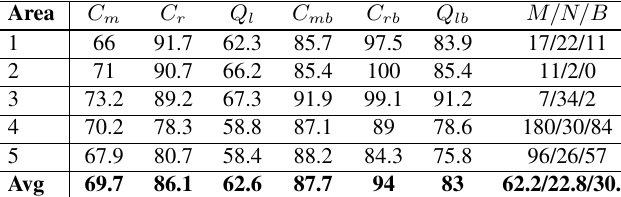
Table 3: Object-based evaluation of plane extraction results. Object-based: C m = completeness, C r = correctness and Q quality ( C , C and Q are for planes over 10 m 2 ) in percent- mb rb lb age. Segmentation errors: M = over-segmentation, N = under- segmentation and B = both over- and under-segmentation.